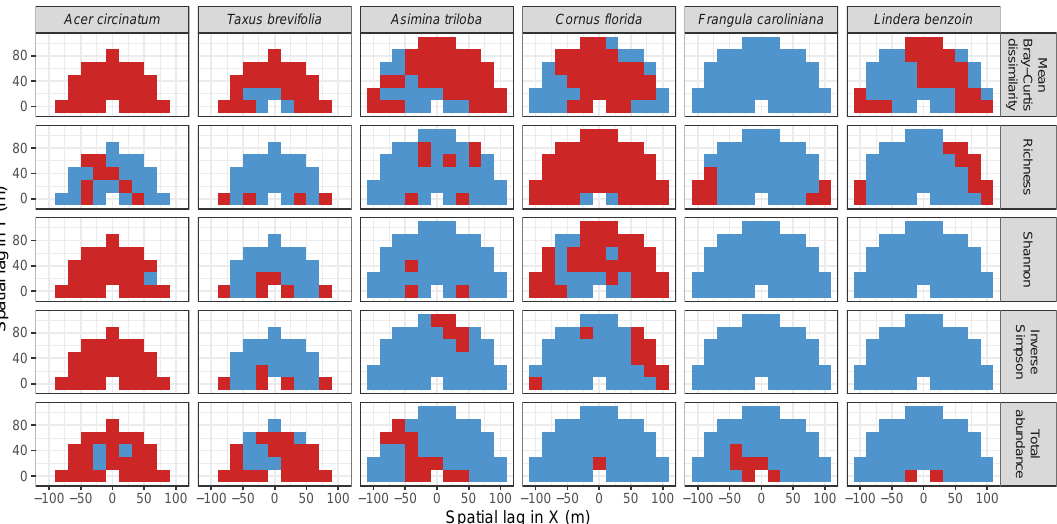
Figure A7. Statistical significance (red: P ≤ 0.05; blue: P > 0.05) of the codispersion coefficients calculated between measures of diversity and total basal area of the focal understory species in 20 × 20-m subplots in the 25.6-ha Wind River ( Acer circinatum, Taxus brevifolia ) and 20-ha Tyson Research Center ( Asimina triloba, Cornus florida, Frangula caroliniana, Lindera benzoin ) plots (Figure A6). Statistical significance was determined by comparing observed codispersion at each spatial lag with a distribution of 199 spatial randomizations of a toroidal shift model.